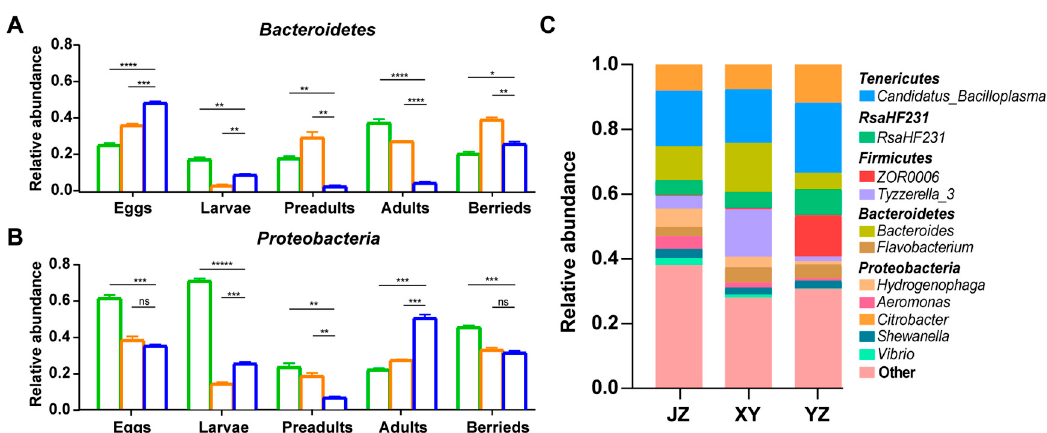
Figure 7. Changes of Bacteroidetes and Proteobacteria during developments. The relative abundance of Bacteroidetes ( A ) and Proteobacteria ( B ) phyla. Green bars: samples from Jingzhou; orange bars: samples from Xuyi; blue bars: samples from Yangzhou. ( C ) The composition of gut microbiota from three locations at the genus level. Significance: * p < 0.05, ** p < 0.01, *** p < 0.001, **** p < 0.0001, ***** p < 0.00001, one-way ANOVA.